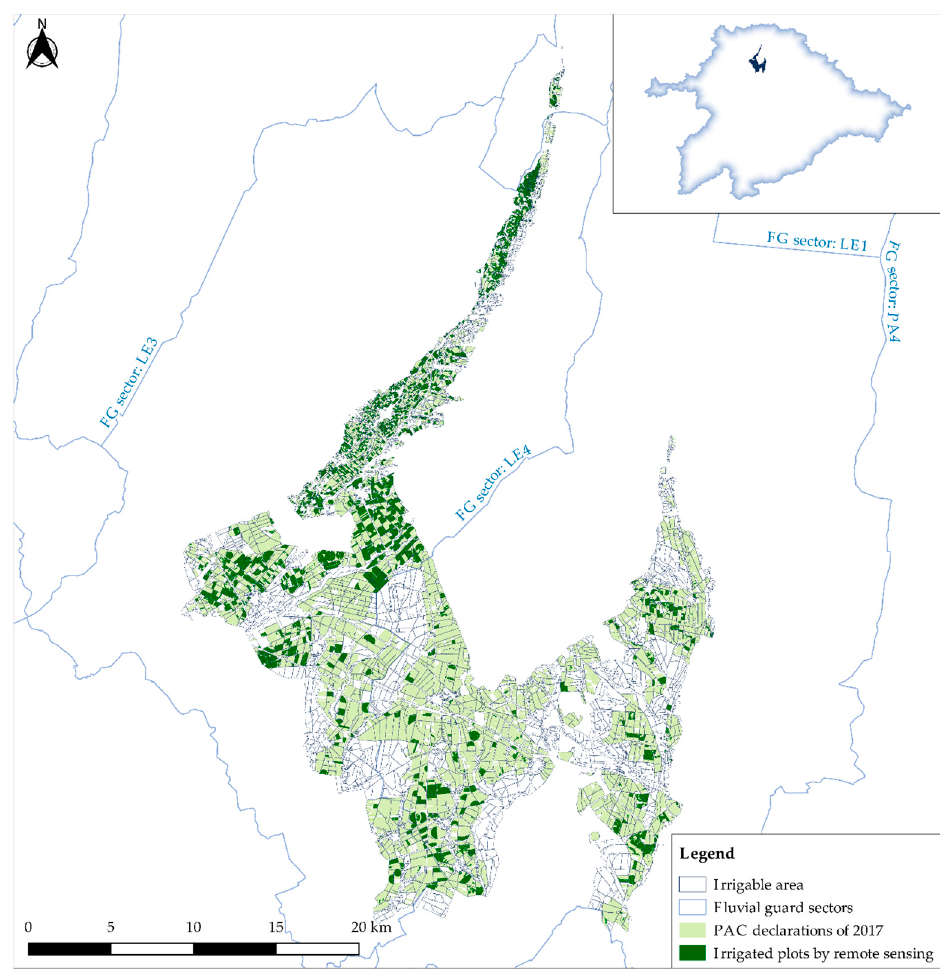
Figure 8. Comparison between the estimation of the irrigated area offered by HidroMap and extension declared for that purpose by the water users of Payuelos for the summer of 2017.